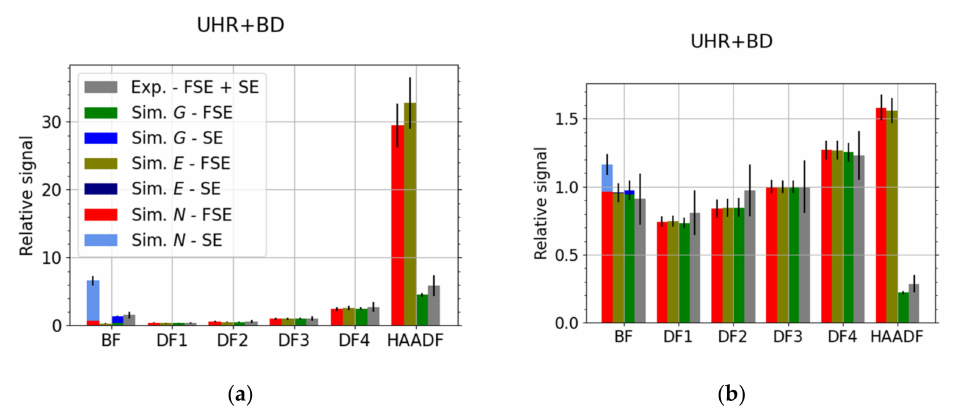
Figure 10. ( a ) Mo and ( b ) C; comparison of simulated and experimental data for UHR + BD micro- scope mode, E L = 15 keV. Simulation data at the best-match thickness contains all three (from left to right): electron counts N , total energy dose E and the calibrated (CC-based) total grayscale G . The data have been scaled to the segment